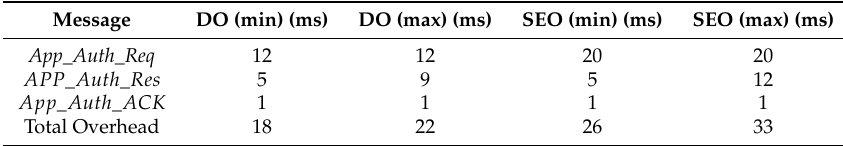
Table 14. Overhead for the proposed protocol (DO and SEO) over a low-power